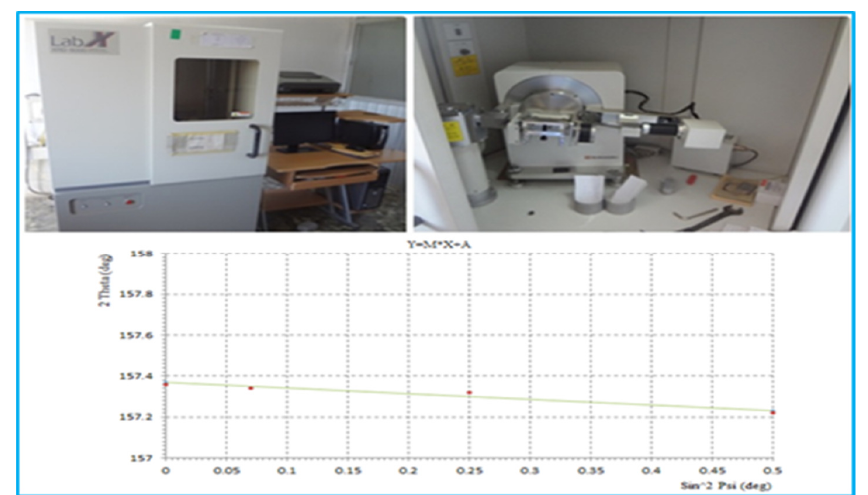
Fig. 9. Residual stress measurement result.